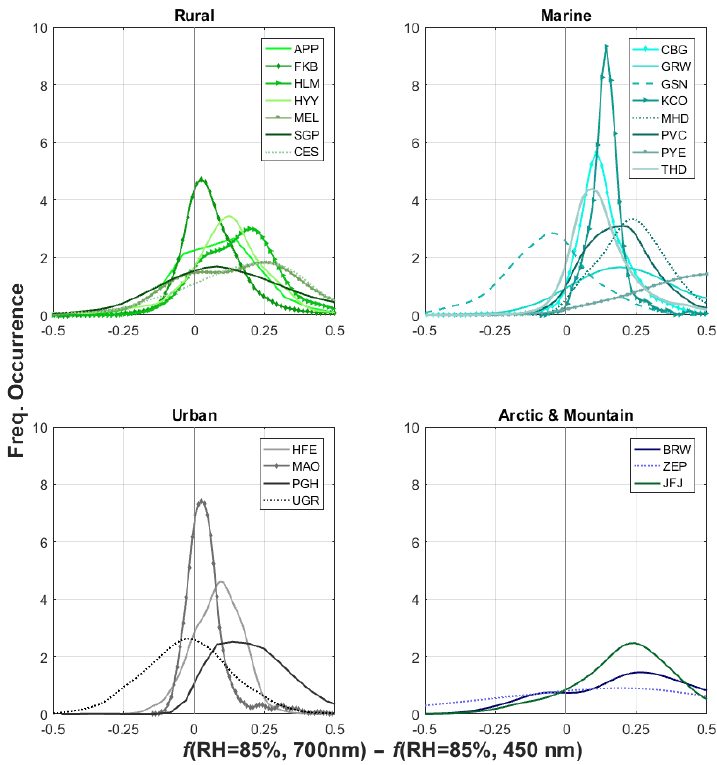
Figure 4. Frequency of occurrence of the difference in the f (RH = 85%) at 700 and 450nm segregated by site